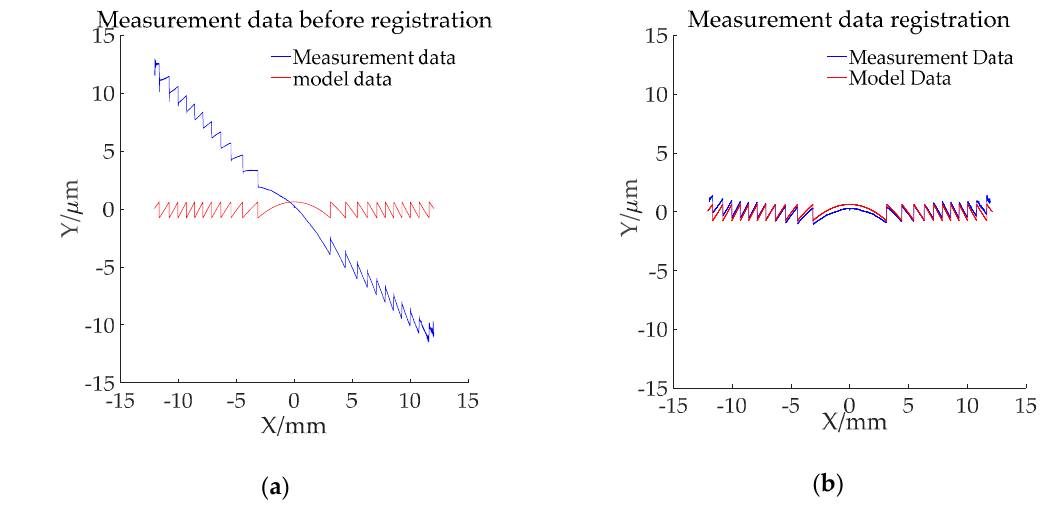
Figure 5. Illustration of the data matching process.